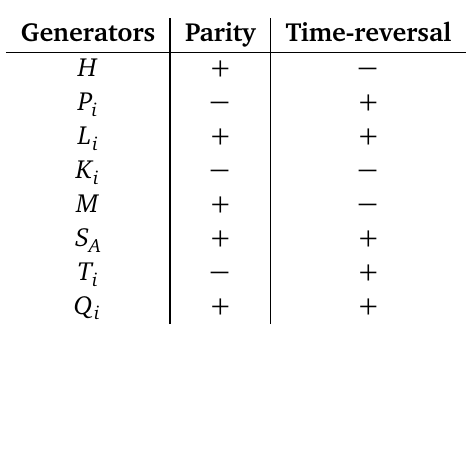
Table 2: Transformation properties of various symmetry generators under parity and time-reversal. Each generator X in the first column transforms as iX → ± iX with the appropriate sign shown in the second and third